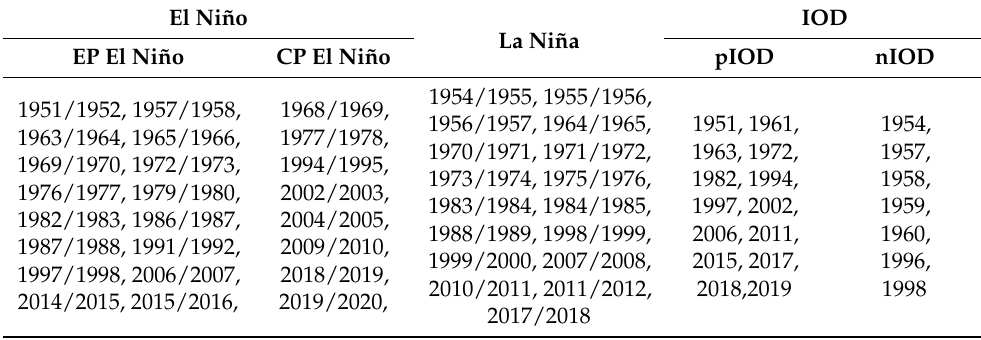
Table 1. List of El Niño, La Niña, and IOD events during